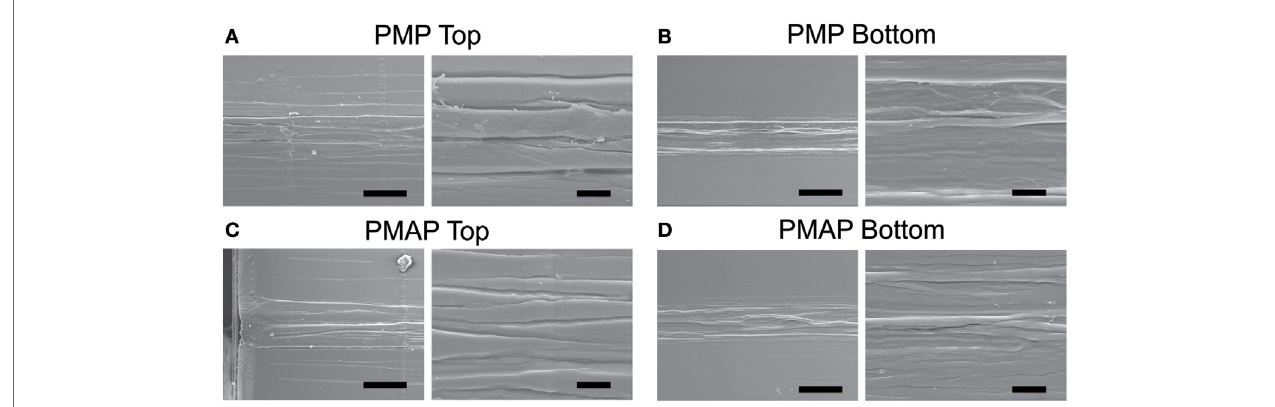
device (images on the right side of each panel are zoomed in views of images on the left with scale bars of the left and right images being 50 and 10 μ m, respectively. Parylene sputtered coated with Pt before